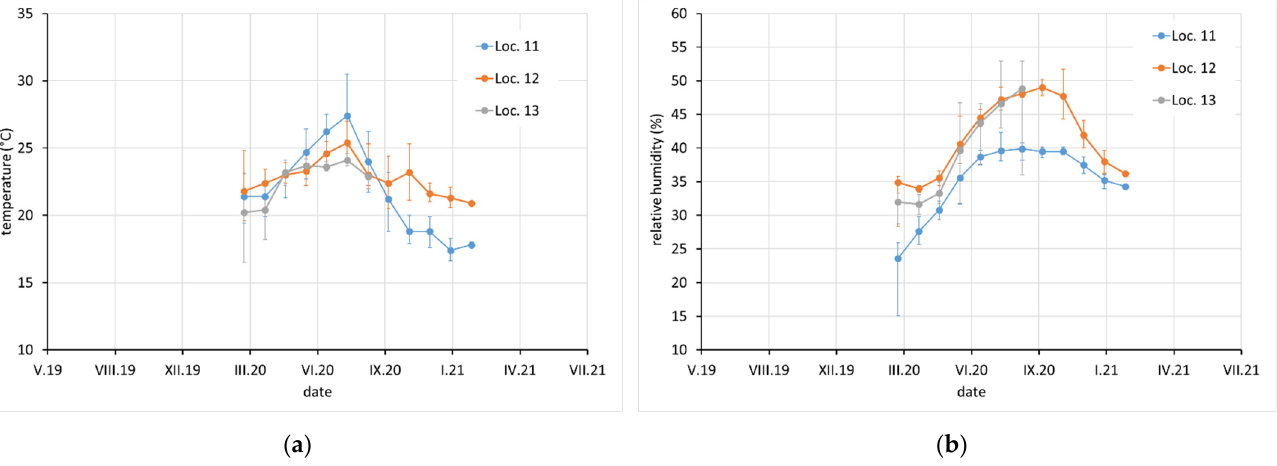
Figure 4. ( a ) Temperature and ( b ) relative humidity record at locations 11, 12, and 13. Points indicate average monthly values and error bars indicate monthly minimum and maximum.